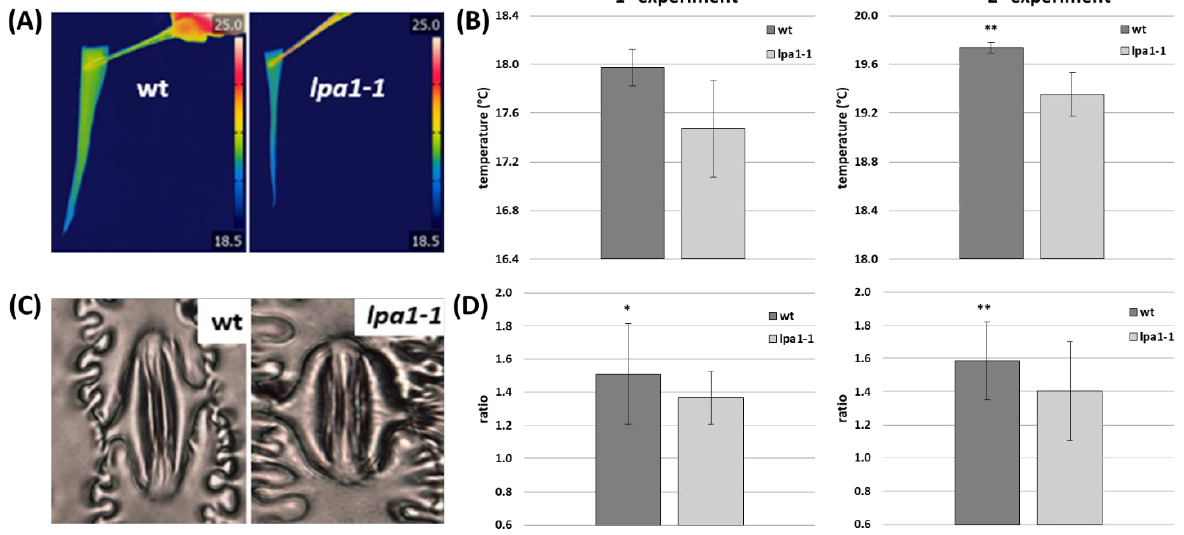
Figure 8. ( A ) Representative images of the leaf temperature acquired with the thermographic camera (FLIR T650sc) in wild-type and homozygous lpa1-1 plants. ( B ) Temperature of the fifth fully expanded leaf in the wild-type and lpa1-1 homozygous plants measured at 60 days after sowing (DAS). Values represent the mean of three biological replicates in two different experiments. Significant differences between wild-type and lpa1-1 were assessed by Student’s t -test (* p < 0.1 and ** p < 0.05). ( C ) Representative images of the stoma acquired by optical microscope on the fifth fully expanded leaf in wild-type and lpa1-1 mutant plants at 60 DAS. ( D ) Ratio between the long side and the short side of the stoma. This parameter gives us an indication about the shape of the stoma and its opening: the higher the ratio, the more elongated the shape; if the ratio is close to 1, the stoma has a circular shape. Values represent the mean of eighteen biological replicates. Significant differences between wild-type and lpa1-1 were assessed by Student’s t -test (* p < 0.1 and ** p < 0.05). Hence, it seems that the mutant plant suffers more from drought stress compared to the control line. Consequently, the efficiency of photosystem II measured with the fluo- rometer should also decrease. The parameter Fv/Fm represents the maximum quantum efficiency of PSII and gives information on the potential photosynthetic ability of the